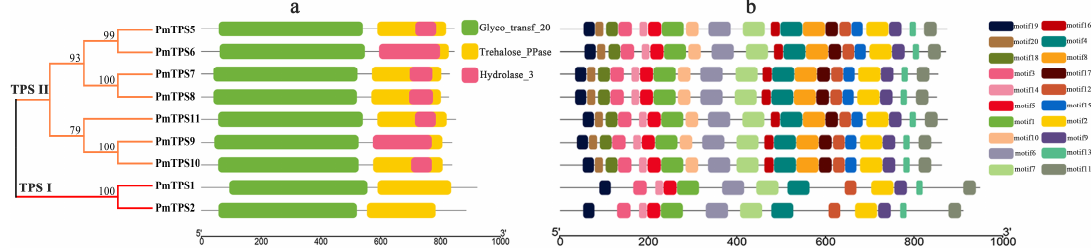
Figure 5. Protein conserved domains and motifs distribution of TPS family members in P. mume . ( a ) The protein conserved domains, glycosyltransferase 20 family (Glyco_transf_20), trehalose phosphatase (Trehalose_PPase), and haloacid dehalogenase-like hydrolase (Hydrolase_3) domains are presented by green, yellow, and pink round-corner rectangle, respectively. ( b ) Motif compositions of TPSs in P. mume . The distributions of 20 conserved motifs are represented by different colored boxes.